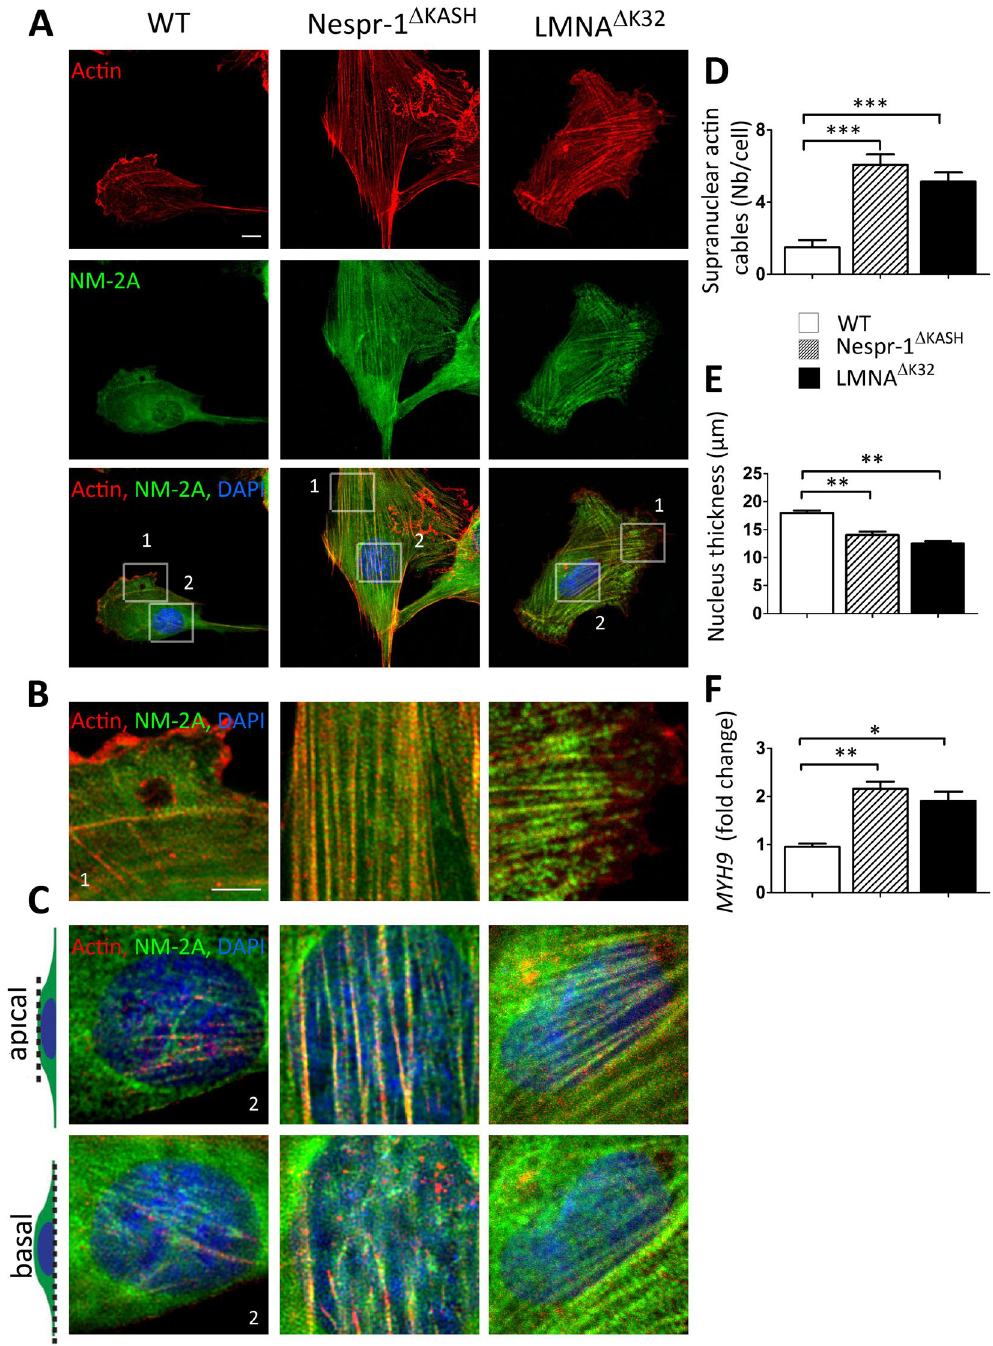
Figure 2. Actin cytoskeleton on soft matrix (12 kPa). ( A ) Confocal images of WT, Nespr-1 Δ KASH and LMNA Δ K32 myoblasts on soft matrix (12 kPa) close to physiological muscle stiffness and stained for F-actin (phalloidin, red) and non-muscle myosin 2 A (NM-2A, green). Nuclei are stained with DAPI (blue). Scale bar: 10 µ m. ( B , C ) Zoom-in of actin cytoskeleton at the cell periphery ( B ) and in the perinuclear regions ( C ). In C, confocal images are taken at the apical and basal surface of the cell. Scale bar: 5 µ m. ( D ) Supranuclear actin cable number in WT, Nespr-1 Δ KASH and LMNA Δ K32 myoblasts. Values are means ± SEM; *** p < 0.001 compared with WT. ( E ) Nuclear thickness in WT, Nespr-1 Δ KASH and LMNA Δ K32 myoblasts. Values are means ± SEM; ** p < 0.01 compared with WT. ( F ) mRNA expression of MYH9 gene expression coding for NM-2A in WT, Nespr-1 Δ KASH and LMNA Δ K32 myoblasts. Values are means ± SEM; ** p < 0.01, * p < 0.05 compared with